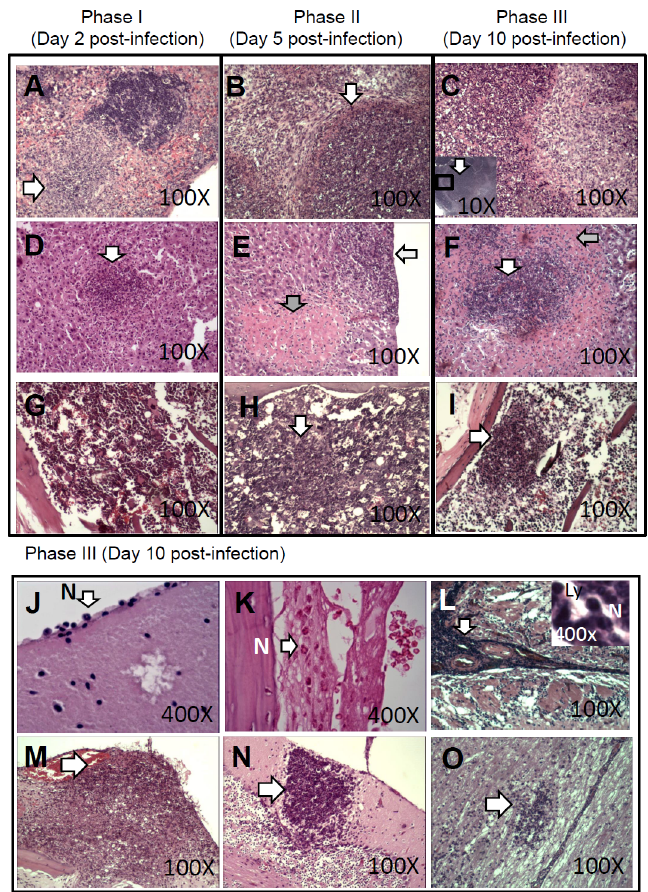
Figure 1. Histological examination. H&E staining of infected tissue was performed on days 2 (phase I), 5 (phase II) and 10 (phase III). Based on observations of the spleen, abscesses (indicated by arrows) occurred during phases I (A, 100 6 ), II (B, 100 6 ) and III (C, 100 6 ). The lesions became very large during phase III (magnification, 10 6 ; lower left corner of C). Based on observations of the liver, abscesses consisting of degraded neutrophils and cellular debris (indicated by white arrows) occurred during phases I (D, 100 6 ), II (E, 100 6 ) and III (F, 100 6 ). Necrotic hepatocytes (indicated by gray arrows) were present in phase II and expanded during phase III. Normal hematogenous cells were observed in the BM during phase I (G, a representative femur image; 100 6 ), and cellular debris (indicated by arrows) was present in the femur and vertebrae during phases II (H, a representative vertebral image; 100 6 ) and III (I, a representative femur image; 100 6 ). Because brain histological changes did not occur during phases I and II, only representative images of sections prepared during phase III are shown, including neutrophil (N) migration in cerebral margins (J, 400 6 ), neutrophil infiltration in the meningeal subarachnoid space (K, 400 6 ) and the accumulation of darkly stained cells (indicated by arrows) in the meninges (L, 100 6 ). Using high magnification, both neutrophils (N) and lymphocytes (Ly) were observed (400 6 ; upper right corner in L). Severe histopathological changes (indicated by arrows), including suppurative meningitis (M, 100 6 ), cerebellar microabscess (N, 100 6 ) and brain stem encephalitis (O, 100 6 ), are